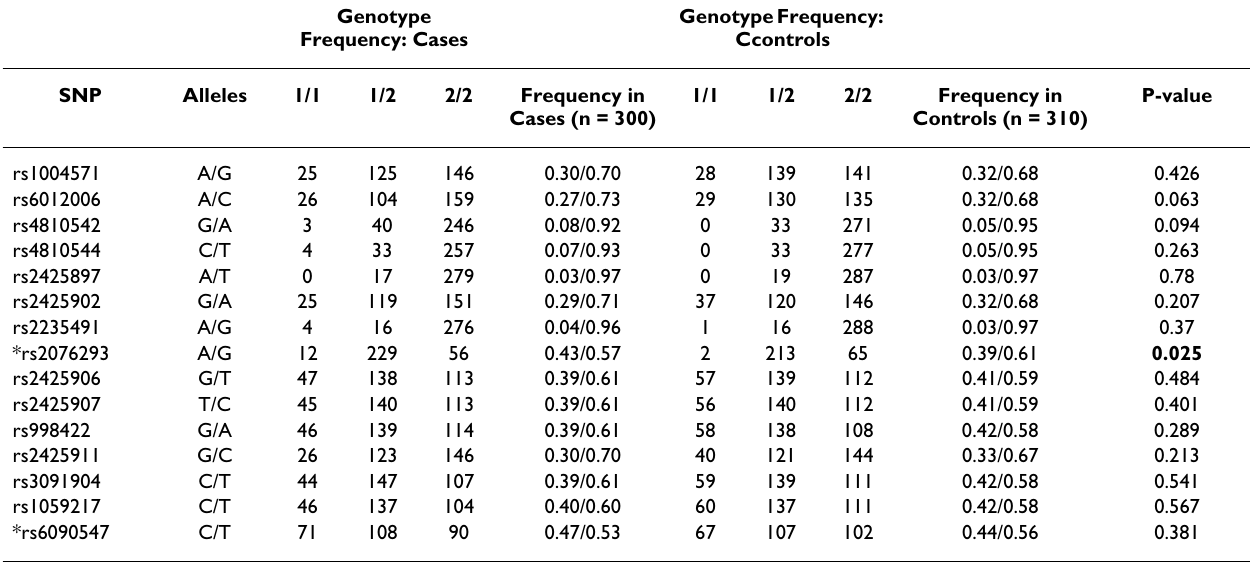
*Variant not consistent with Hardy-Weinberg proportions P-values in bold indicates P ≤